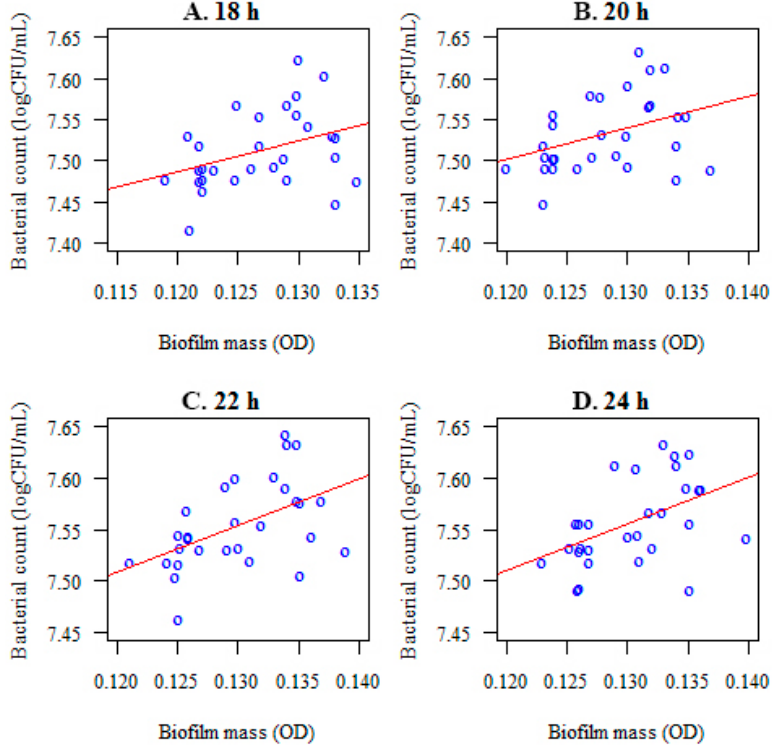
Figure 10. Correlations between the number of microorganisms forming biofilm ( S. mutans ) colony